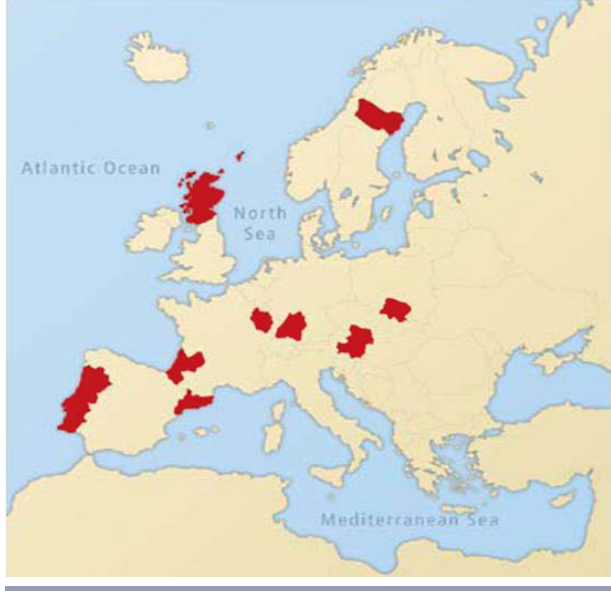
Fig. 1 . Location of reference